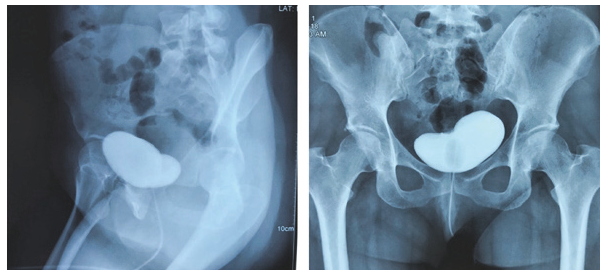
Figure 5: Retrograde cystography image (bladder X-ray) after instillation of iopromide solution (Ultravist (cid:2) ), revealing bladder integrity with no